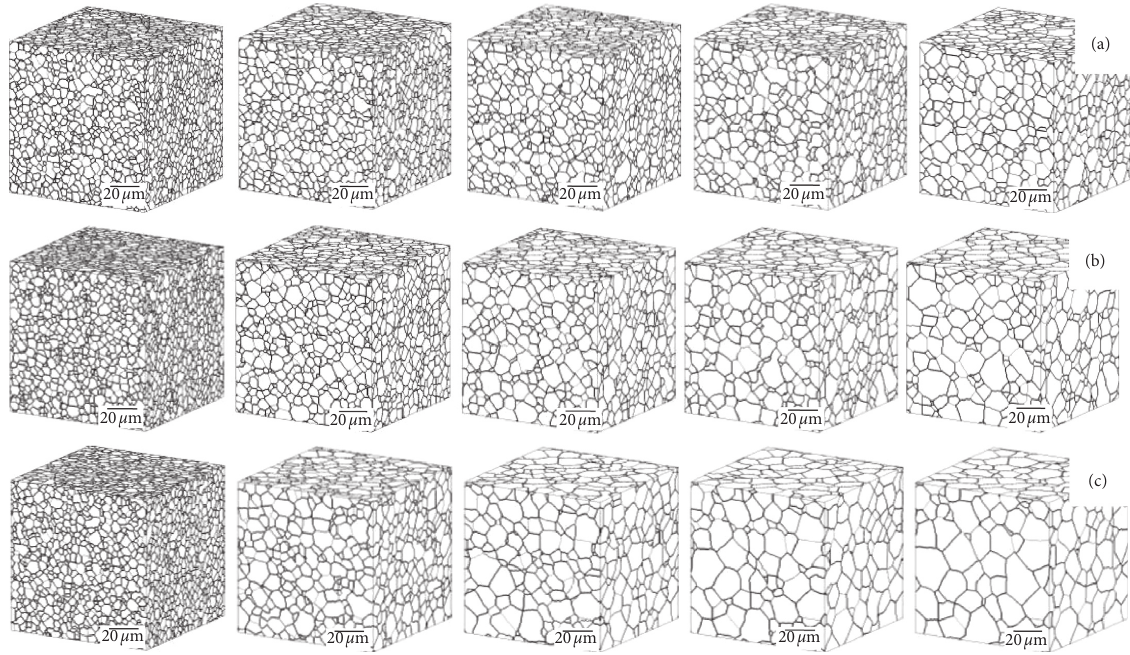
Figure 3: 3D grain growth at different temperatures: (a) 300 ° C, (b) 380 ° C, and (c) 420 ° C.